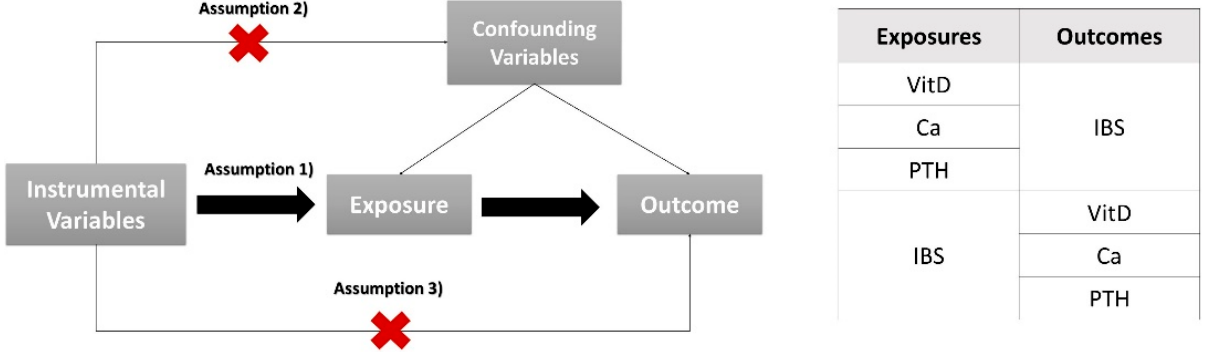
Figure 1. ( Left ): a schematic diagram showing three assumptions of MR; ( Right ): overview of the exposures and outcomes in our MR analysis. VitD, 25-Hydroxyvitamin D; Ca, calcium; PTH, parathyroid hormone; IBS, irritable bowel syndrome.